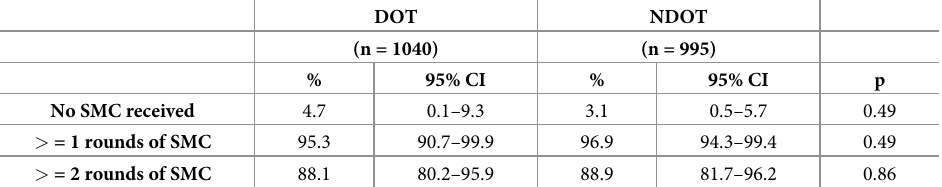
Table 5. Proportions of children who received none, at least one, or at least two rounds of SMC according to the method of observation of the treatment (directly observed treatment versus not directly observed treatment). DOT NDOT (n = 1040) (n =